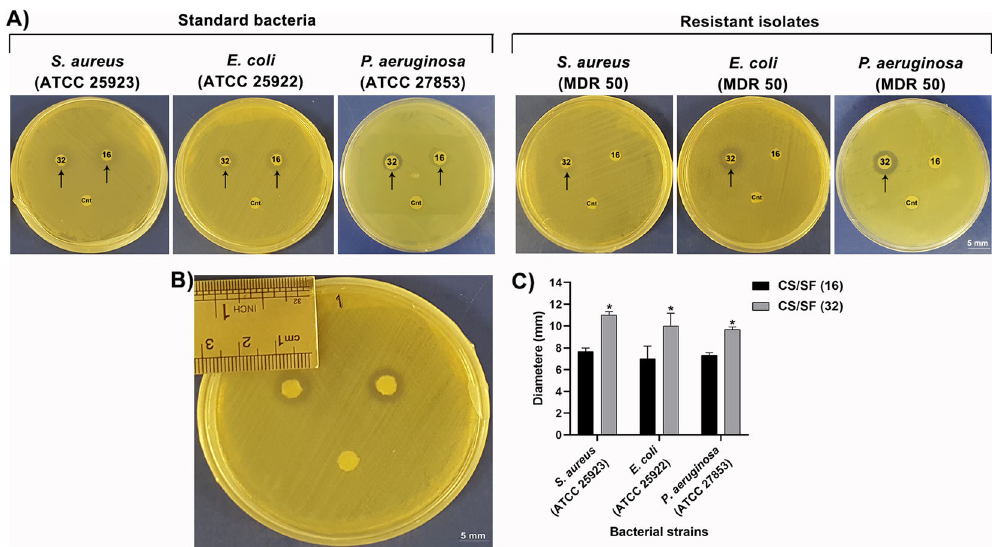
Fig. 7 Assessment of antibacterial activity peptide-loaded CS/FS by disk diffusion assay. A The antibacterial activity peptide-loaded CS/SF (16 & 32 µg/ml peptide, respectively) bilayers are compared with control (Cnt). A halo around peptide-loaded bilayers is visible after 24 h in standard strains of S. aureus, E. coli , and P. aeruginosa MHA plates compared to control disks. In resistant strains, an inhibition zone is observable only around CS/SF containing 32 µg/ml CM11 peptide. B The diameter of the growth inhibition zone recorded by a